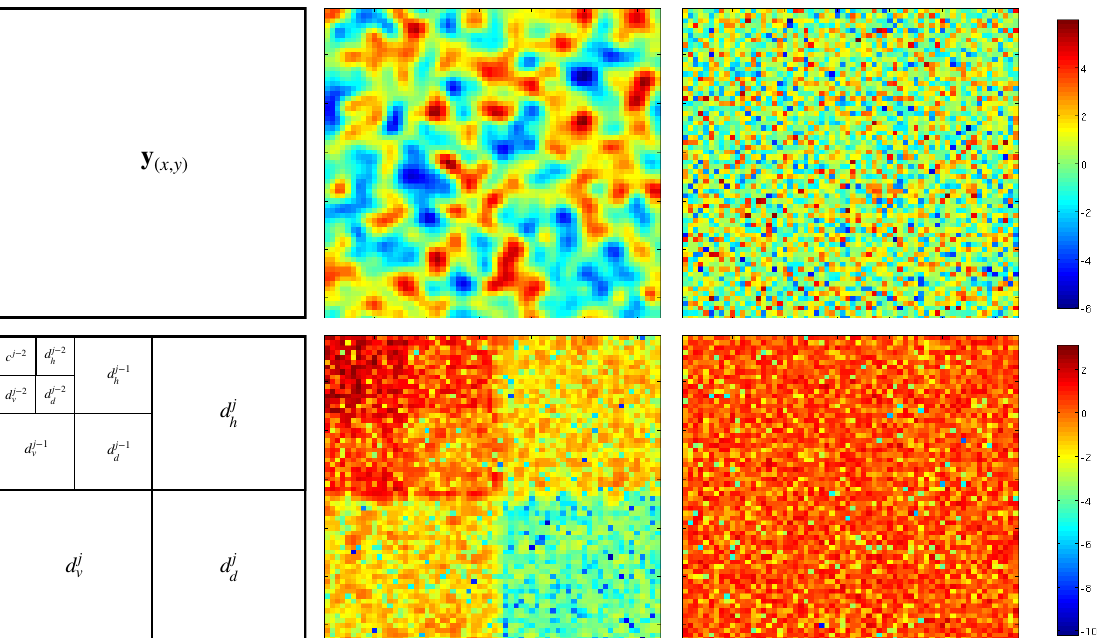
Figure 2. Top middle (resp right) panel shows an example of correlated (resp uncorrelated) noise. Figure 5.6 – L’image en haut à gauche présente un exemple de bruit corrélé en espace tandis qu’en haut à droite un bruit décorrélé en espace est présenté. En bas à gauche est présen- On bottom left, the scheme of the organisation of wavelet coefficient with three scales. On bottom tée le logarithme (en base 10) de la valeur absolue des coefficients dans une base d’ondelettes middle (resp right), the logarithm of the absolute value in wavelet space of the correlated (resp c j,k,l (log 10 ) correspondant à la décomposition du bruit corrélé en espace. Le stockage des co- | | uncorrelated) noise. We can see that approximation coefficient ( c j − 2 ) are significantly larger than small efficients dans une base d’ondelettes est organisé comme décrit en figure 5.5. En bas à droite, la scale details coefficients ( d j ∗ même chose est présentée pour le bruit indépendant en espace.